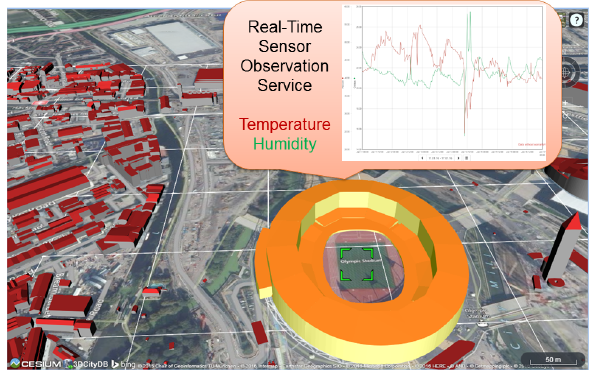
Figure 1. Sensor observations for temperature and humidity vari- ations in a room of a building.